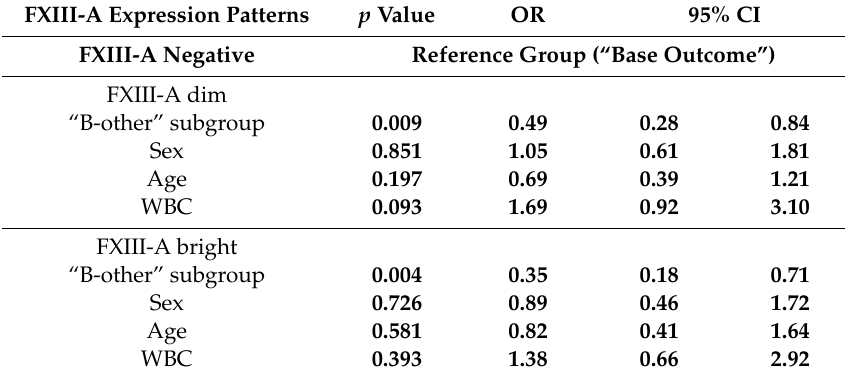
Table 4. Correlation of FXIII-A expression patterns with conventional clinical and “B-other” subgroup by multinomial logistic regression